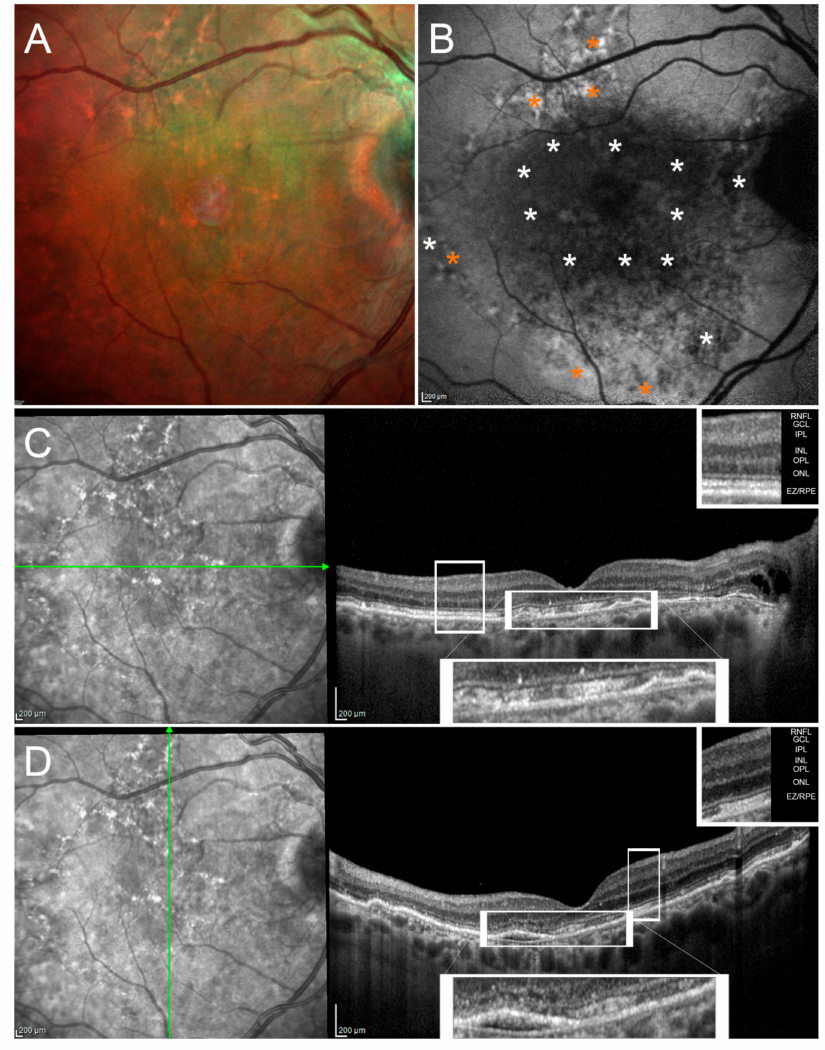
Figure 2. Chronic central serous chorioretinopathy. Multicolor ( A ) and BAF ( B ) images disclose sparse alterations over the entire posterior pole, characterized both by hypoautofluorescent (white asterisks) and hyperautofluorescent (orange asterisks) signals. Horizontal ( C ) and vertical ( D ) high-resolution structural OCT scans reveal the presence of diffuse alterations of the outer retinal bands, better highlighted in magnified pictures, with an irregular profile of the RPE and attenuated reflectivity signal. The OCT layers legend is provided in the upper-right part of the images. The following abbreviations are used: retinal nerve fiber layer (RNFL), ganglion cell layer (GCL), inner plexiform layer (IPL), inner nuclear layer (INL), outer plexiform layer (OPL), outer nuclear layer (ONL), ellipsoid zone/retinal pigment epithelium complex